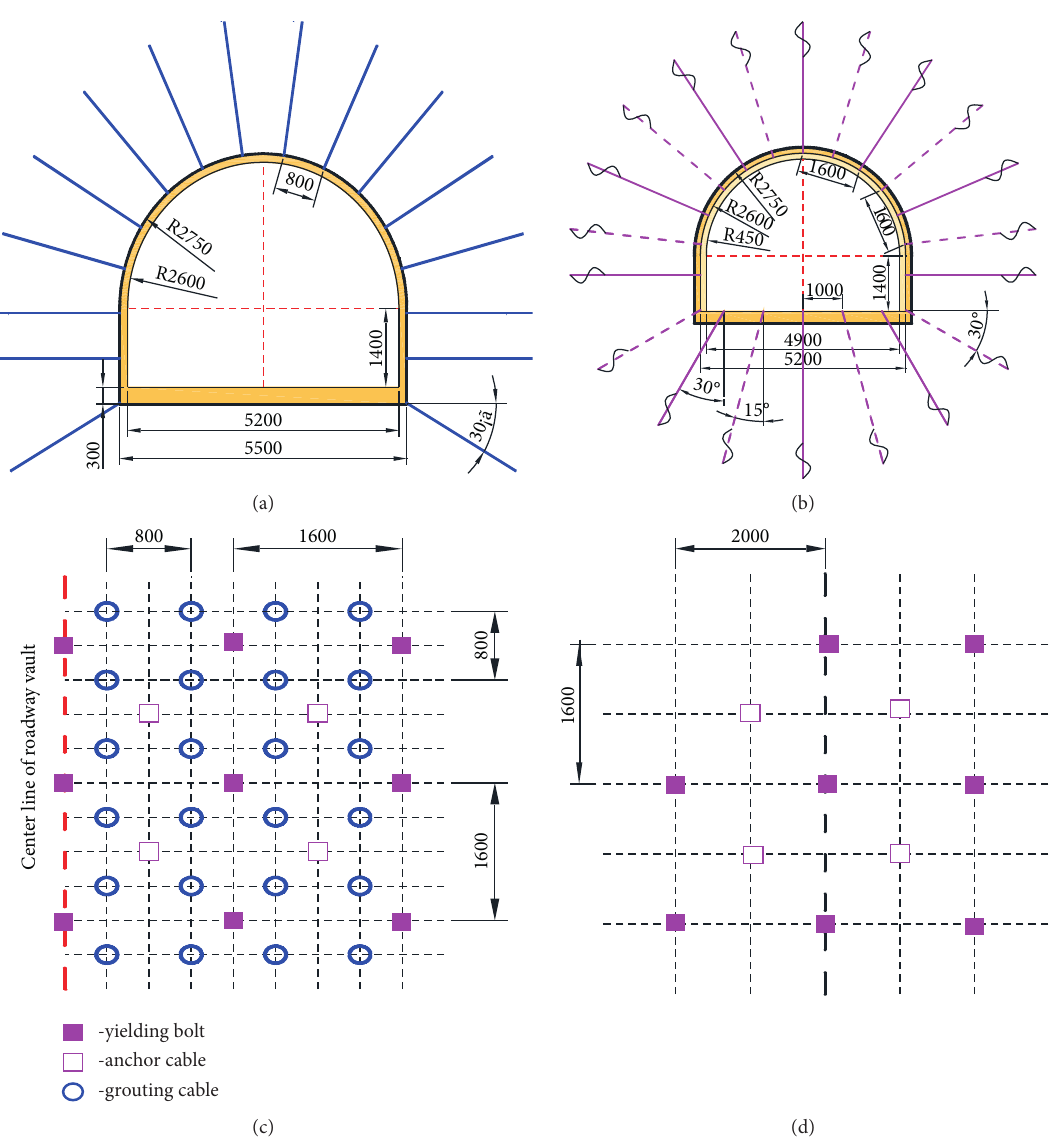
Figure 17: Combined support scheme (Unit: mm). (a) Primary support. (b) Secondary support. (c) Reinforcement of dome and sidewalls. (d) Reinforcement of